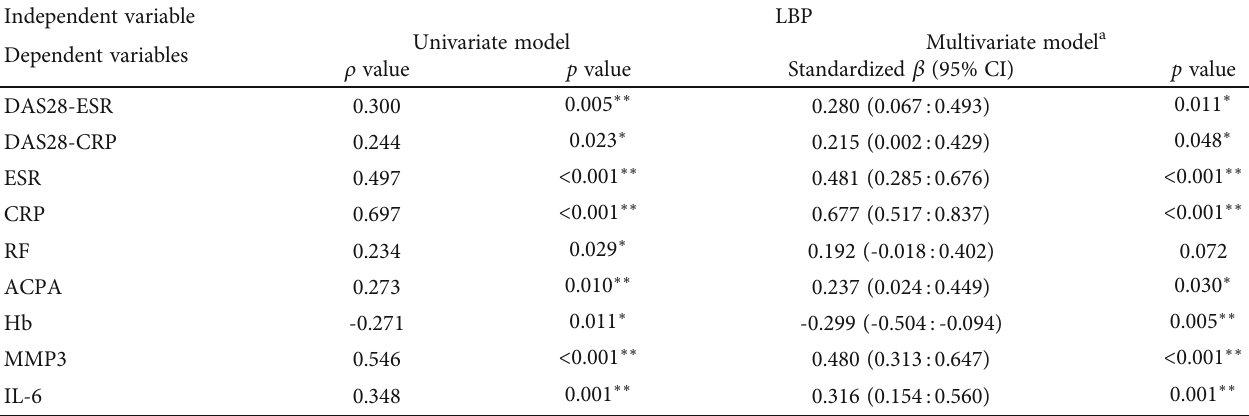
Table 2: Univariate and multivariate regression analysis between serum LBP levels and RA disease markers.